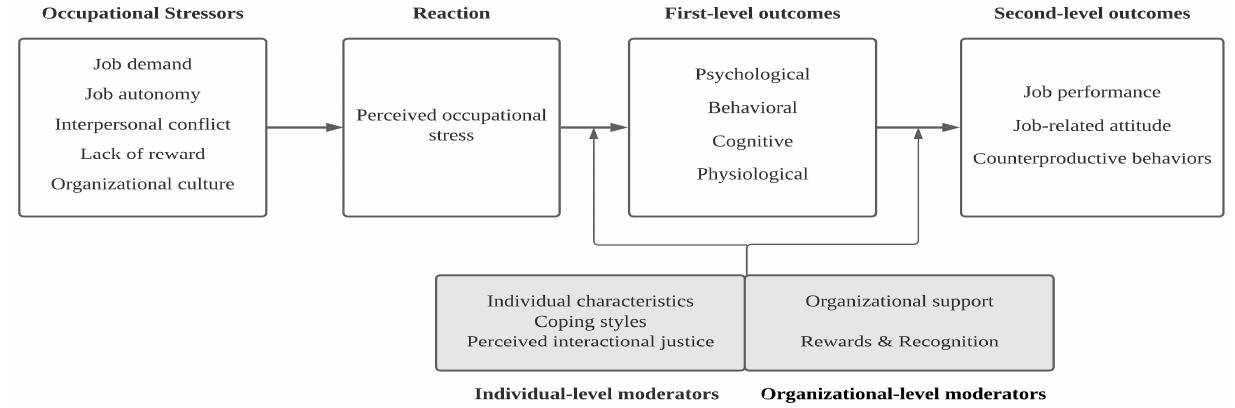
Figure 1. Overall conceptual model of occupational stress for sport leaders.